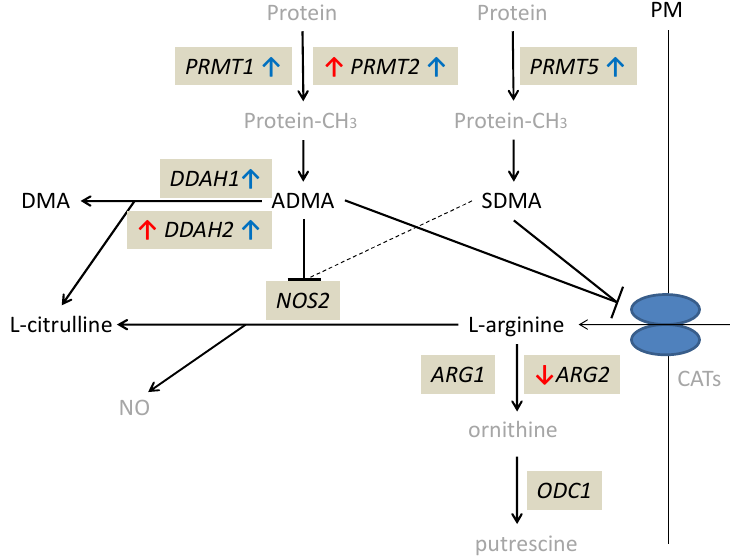
Figure 3. Alterations in expression of L-arginine / NO pathway enzymes in inflamed and quiescent tissue from patients with Crohn’s disease as compared to normal small bowel tissue derived from patients with